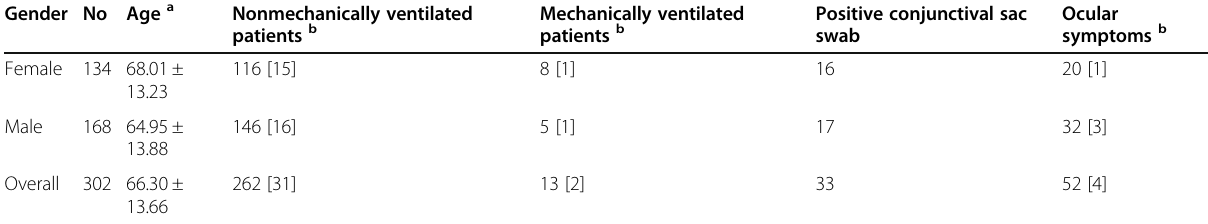
Table 1 The group of all COVID-19 patients and its subgroup with positive PCR test in conjunctival sac swab Gender No Age a Nonmechanically ventilated Mechanically ventilated patients b patients